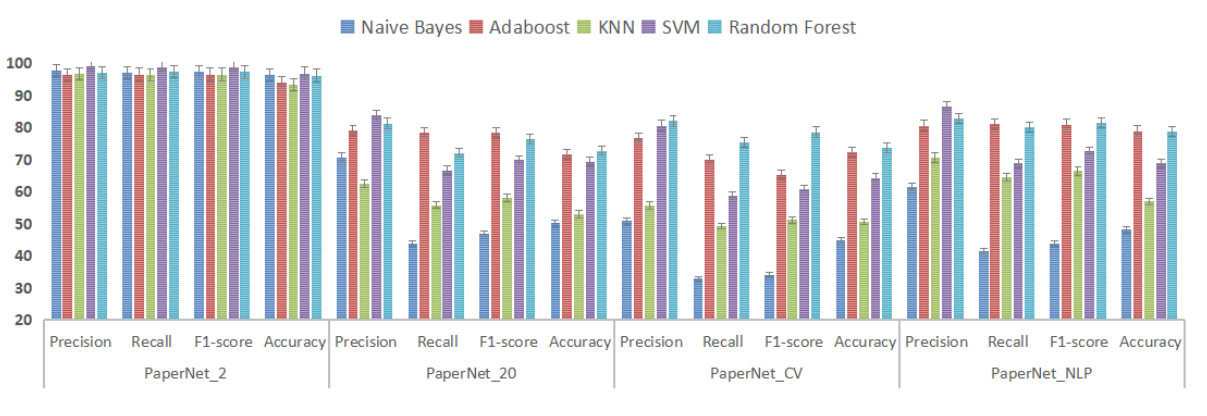
Figure 1. The machine learning algorithm experiments.